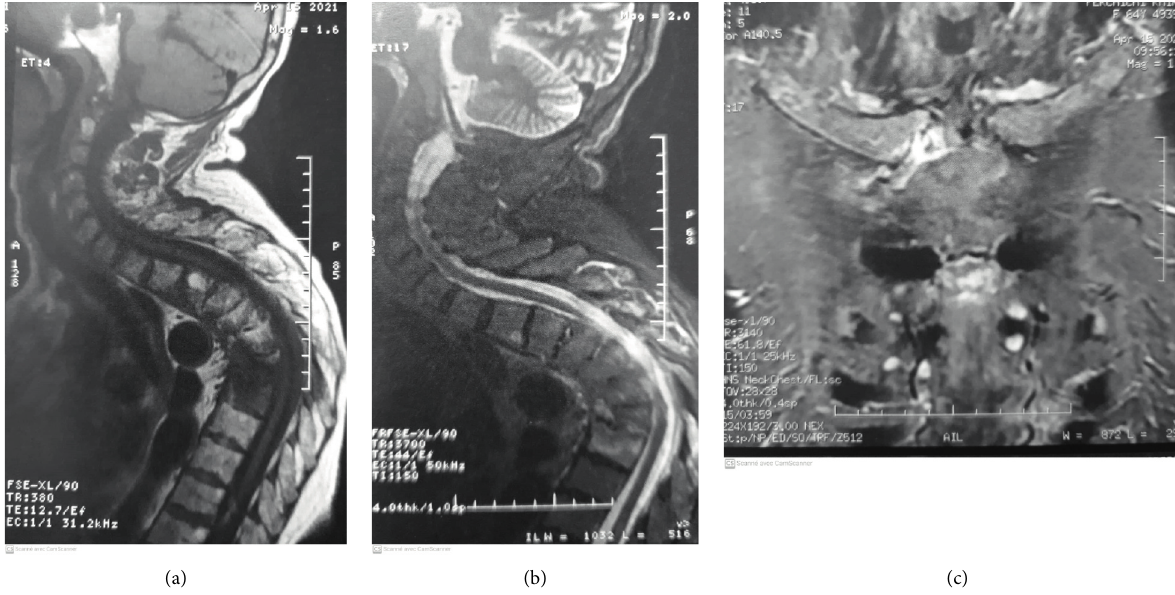
Figure 5: (a–c) Inflammatory marrow signal from T1 to T9 complicated by kyphosis at the top of T7 and associated with inflammatory damage at the anterior chest wall, predominantly the right sternoclavicular